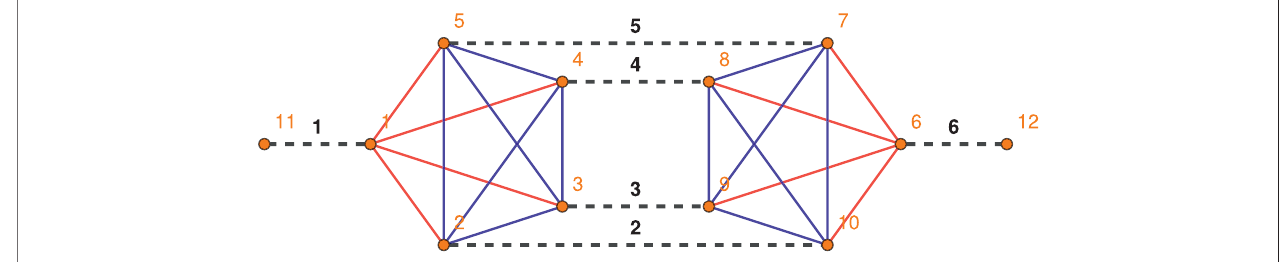
FIGURE 1 | The picture shows the LO (melonic) radiative correction to the simplicial Ooguri model two-point function W 2 .The dashed black lines represent propagators. The solid lines encode the internal structure of each simplicial GFT vertex. A face is an alternate sequences of dashed and solid lines. Blue lines are associated to internal faces while red lines belong to the external ones. The diagram has four external and six internal faces.